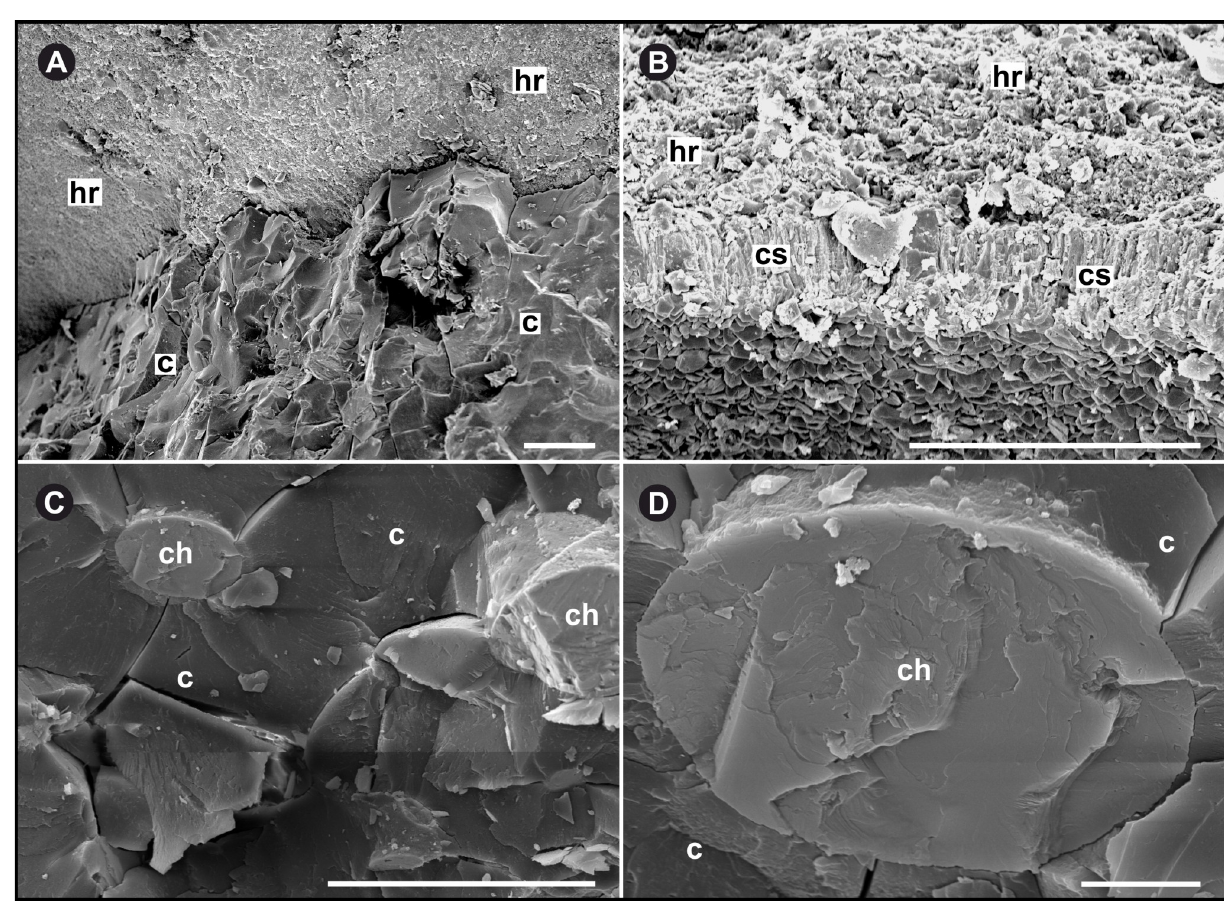
Fig 7. EDS-SEM images of the ultrastructure of specimen NHMW 2012/0117/0024. (A) Distinct boundary between fine calcareous host rock (hr) and carbonized, amorphous fossil (c). (B) Thin calcareous fossil-surrounding seam/layer (cs, approx. 20 μ m thick). (C) EDX-SEM of amorphous structure with calcitic channel fillings. (D) Calcite-filled channel (magnification x 5000; scale bar 10 μ m). hr host rock, c carbonized cartilage, ch calcitic channel fillings, cs calcareous fossil-surrounding seam. Scale bar except (D) 100 μ m.